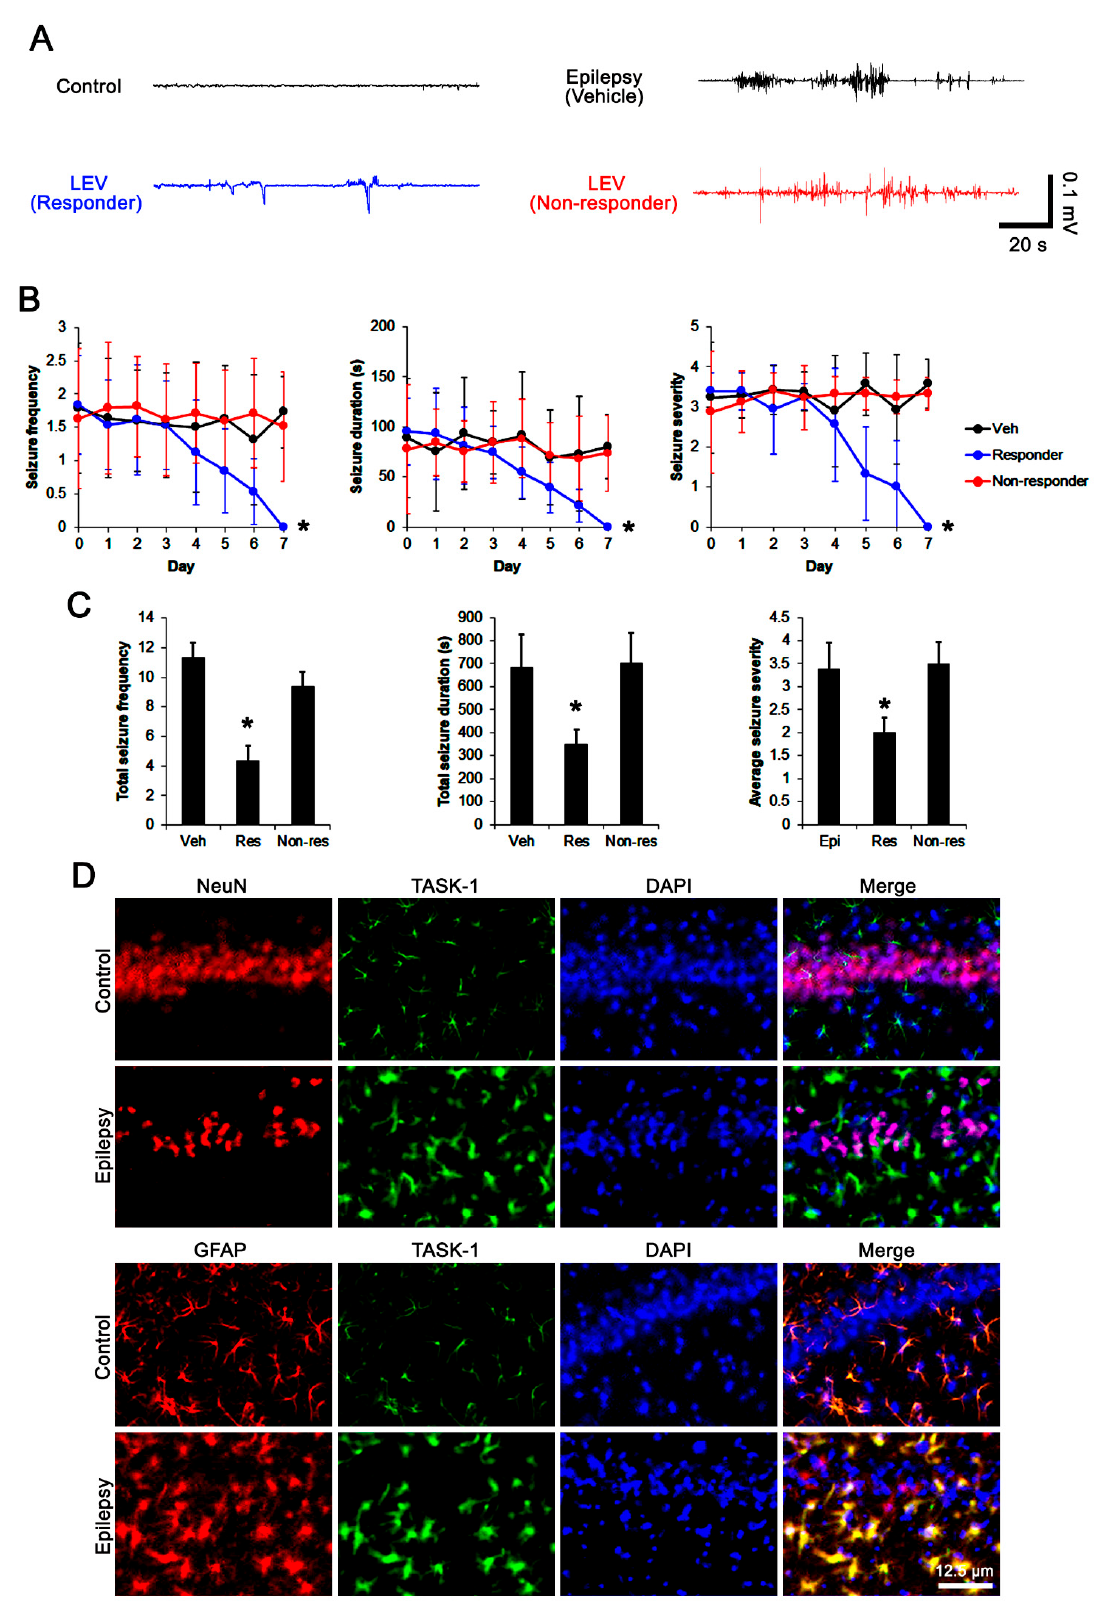
Figure 2. The effects of levetiracetam (LEV) on spontaneous seizure activities in chronically epileptic rats and the localization TASK-1 in the hippocampus of the control and chronically epileptic rats. LEV effectively attenuated spontaneous seizure activity on EEG in responders ( A ) at 4 days